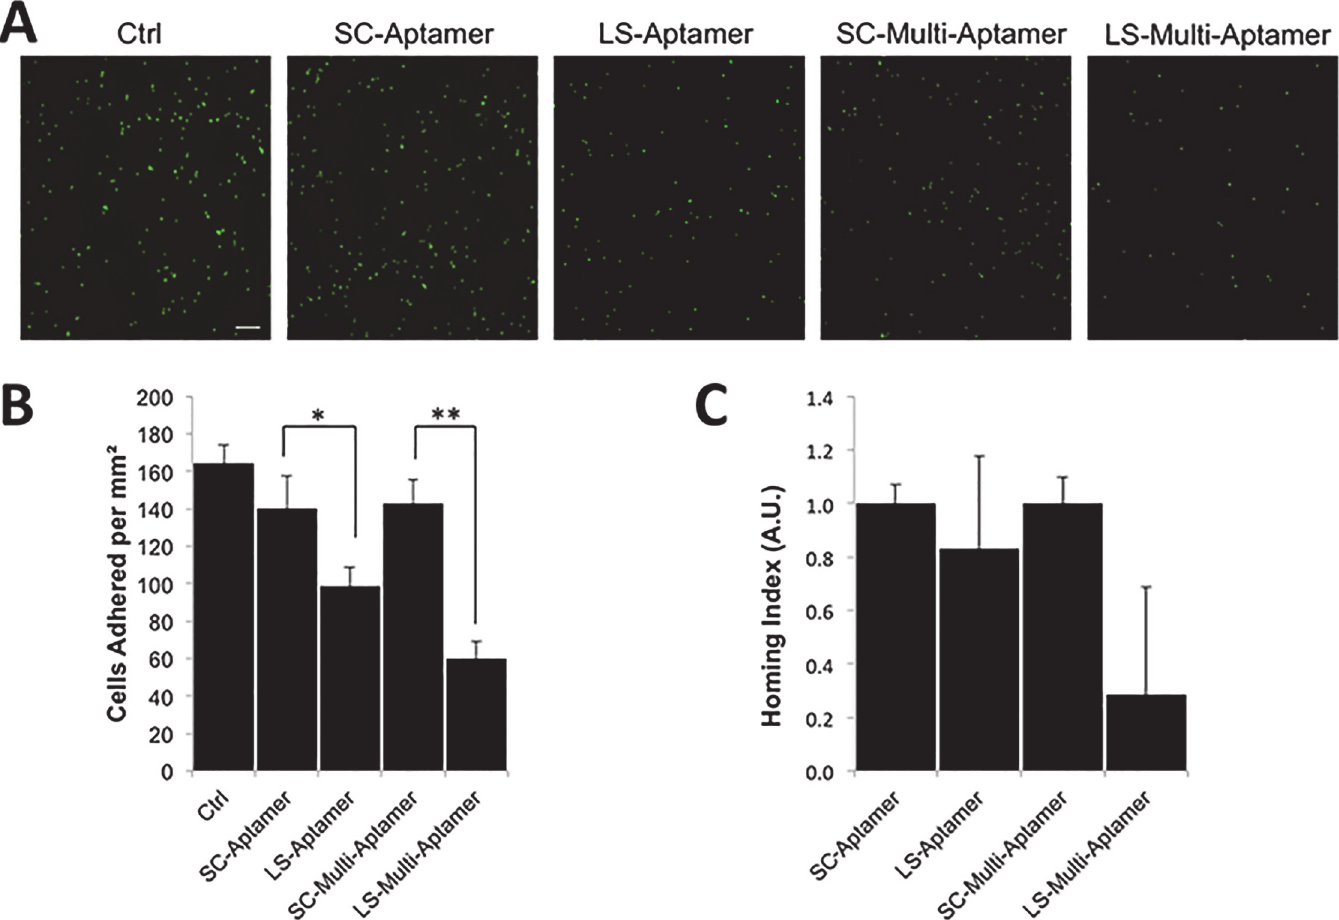
Fig 7. LS-Multi-Aptamer inhibits dynamic adhesion and homing in vitro and in vivo. (A) Representative images of Jurkat cells after dynamic adhesion to activated endothelial cells and treatment with the indicated aptamers or Multi-Aptamers. Scale bar is 20 μ m. (B) Quantification of Jurkat cells that dynamically adhered to activated endothelial cells following the indicated treatments. * p < 0.05; ** p < 0.01. (C) Quantification of relative recruitment of Jurkat cells to the mesenteric lymph nodes following treatment with the monovalent SC- or LS-aptamer or SC- or LS-Multi-Aptamer, normalized to the respective control. Error bars are